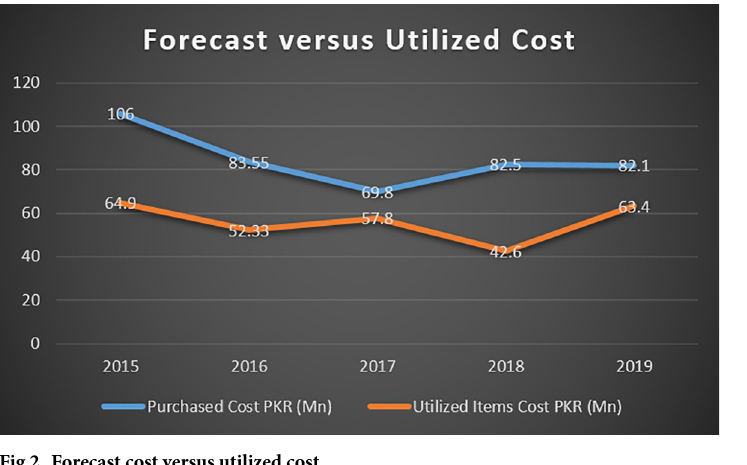
Fig 2. Forecast cost versus utilized cost.